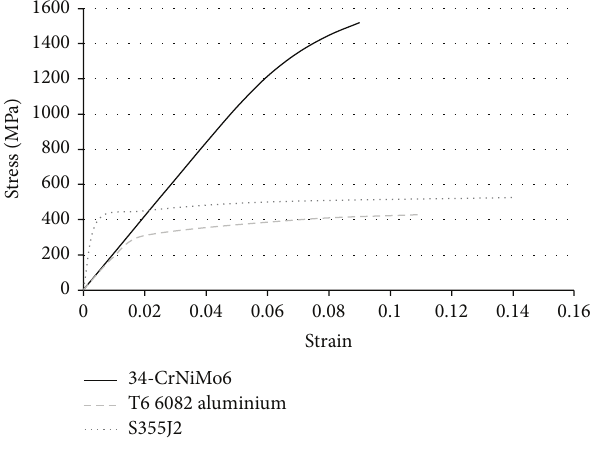
Figure 4: Stress-strain